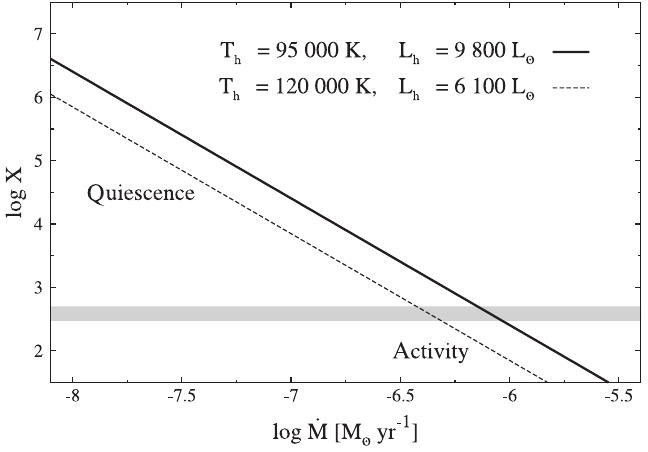
Fig. 2. The value of the parameter X as a function of the mass-loss rate, ˙ M , of the hot star for two different combinations of the temperature T h and luminosity L h , derived by Sokoloski et al. (2006) for the hot component in Z And during its 2000–2003 outburst. The shadow belt corresponds to X = 300–500 from Fig. 1, which lead to creation of the neutral disk-like